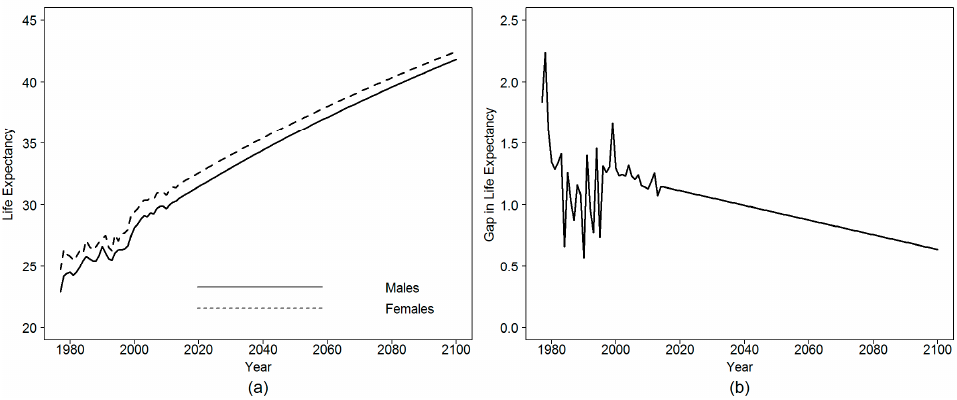
Figure 10 . Projected life expectancy at age 50 for the global population by sex: ( a ) the historical and the expected evolution of the residual life expectancy at age 50 for males and females of the global population (reference population) from 1977 to 2100; and ( b ) the expected evolution of the male–female gap in life expectancy at age 50.